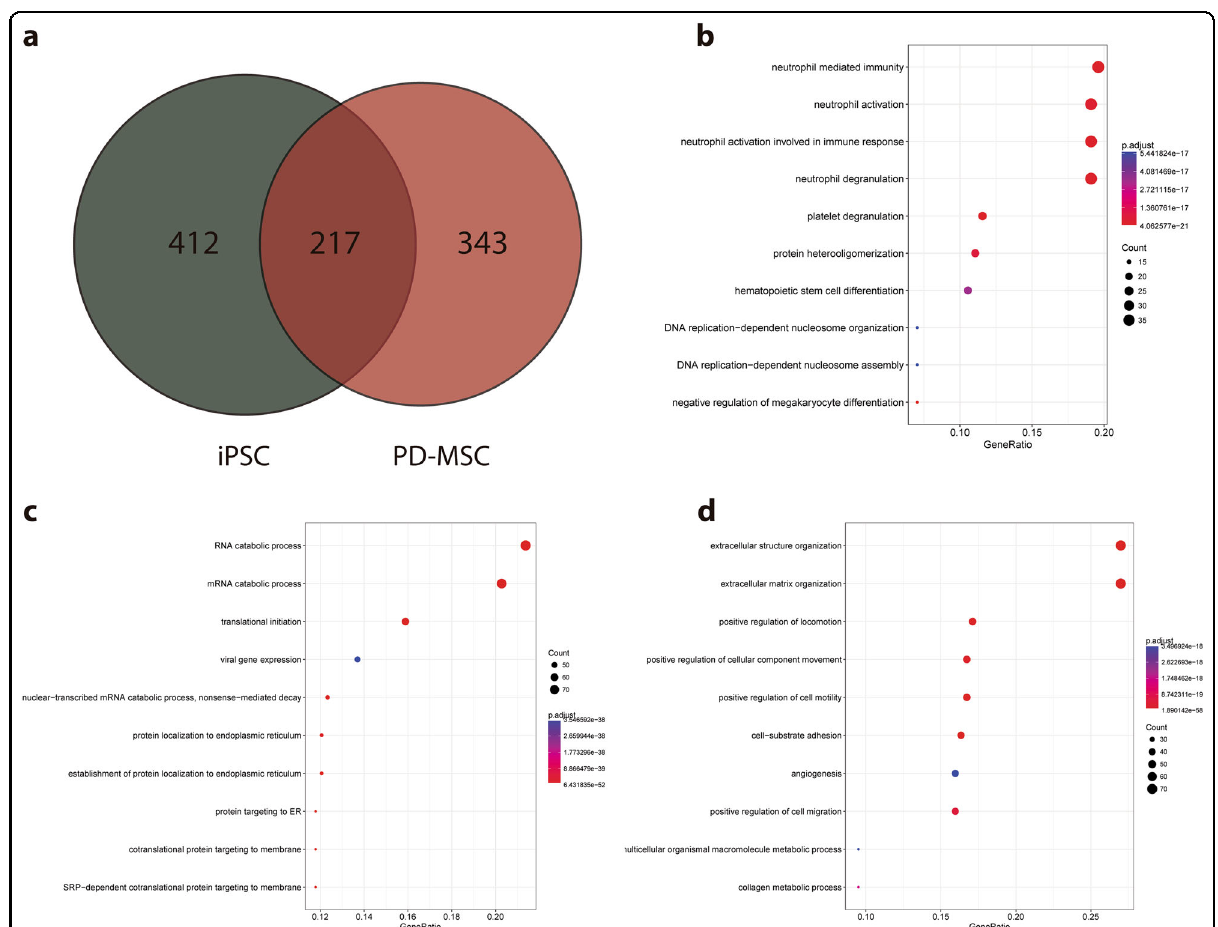
Fig. 2 Comparison between iPSC EVs and PD-MSC EVs. a Venn diagram of UniProt IDs identi fi ed by LC-MS/MS. b Enriched Gene Ontology analysis (Biological Process) of shared UniProt IDs. c Enriched Gene Ontology analysis (Biological Process) of iPSC EV exclusive UniProt IDs. d Enriched Gene Ontology analysis (Biological Process) of PD-MSC EV exclusive UniProt